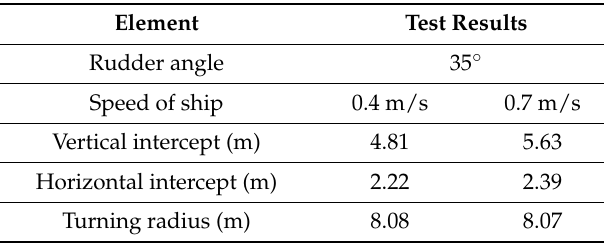
Figure 9. Decay curve of the roll motion.